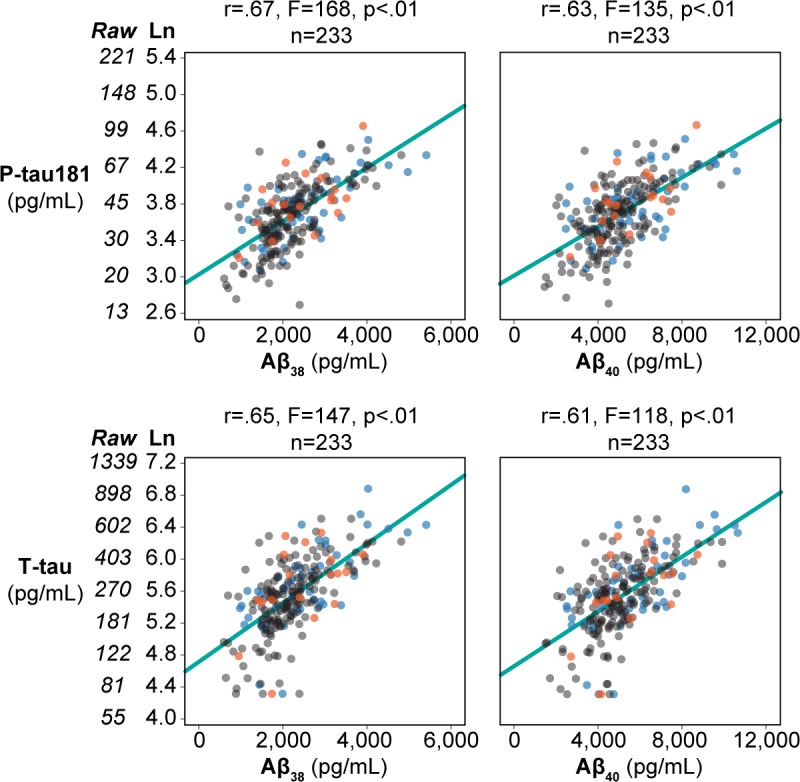
Relationship of X-tau with Aβ38 and Aβ40.Scatter plots for n = 233 depicting Aβ38 and Aβ40 on the x-axis and the natural log transformation of X-Tau (and the associated raw values) on the y-axis. The outcome groups are indicated by color with the cross-sectional NL in blue, Stable NC in gray, and Future MCI/AD in orange. The linear fit is shown as a solid light blue line.